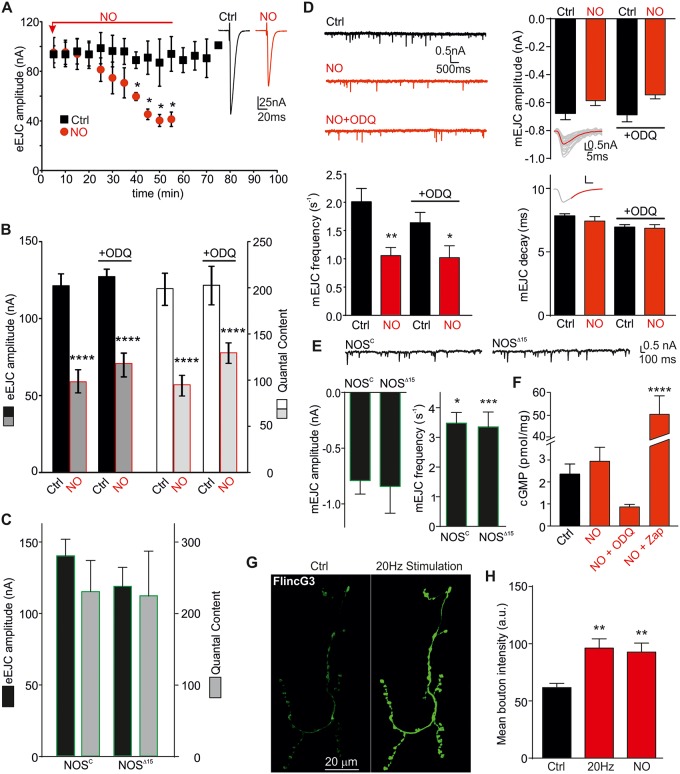
NO reduces evoked release and frequency of spontaneous release in a cGMP-independent manner.(A) NO suppresses evoked release (eEJC) over a time course of 55 min. Insets show representative single eEJCs at 40 min for both conditions. (B) Mean eEJC amplitudes (left axis) and QC (right axis) of w1118 NMJs are reduced following NO exposure (at 40 min). The sGC inhibitor ODQ (50 μM) did not affect the response to NO. (C) Mean eEJC amplitudes (left axis, black) and QC (right axis, grey) of NOSC and NOSΔ15 NMJs. (D) Raw mEJC recordings of w1118 NMJs and mEJC parameters (top to bottom: amplitude, frequency, decay). Top insets show representative mEJC recordings. Bottom insets show single mEJCs (grey) and averaged mEJC (red) with single exponential fit to the decay. (E) Raw mEJC recordings for both NOSC and NOSΔ15 genotypes. Below, mEJC quantal parameters: amplitude and frequency, Student t test each relative to w1118 Ctrl, *p = 0.04, ***p = 0.001. (F) cGMP content of larval brains under the conditions indicated (NO: 40 min NO exposure, NO + ODQ: 40 min NO exposure in the presence of 50 μM ODQ, NO + Zap: 40 min NO exposure + PDE inhibitor Zap, 20 μM). (G) FlincG3 fluorescence images of a Ctrl and stimulated NMJ (20 Hz for 10 s, duty cycle: 1 min for total of 10 min). (H) Summary of FlincG3 fluorescence (in a.u.’s). The raw data can be found in S1 Data. Data denote mean ± SEM in all graphs, ANOVA with post hoc Tukey-Kramer, *p < 0.05, **p < 0.01, ****p < 0.0001. a.u., arbitrary unit; cGMP, cyclic guanosine monophosphate; Ctrl, control; eEJC, evoked EJC; EJC, excitatory junction current; mEJC, miniature EJC; NMJ, neuromuscular junction; NO, nitric oxide; ODQ, 1H-[1,2,4]oxadiazolo[4,3-a]quinoxalin-1-one; PDE, phosphodiesterase; QC, quantal content; sGC, soluble guanylyl cyclase; Zap, zaprinast.